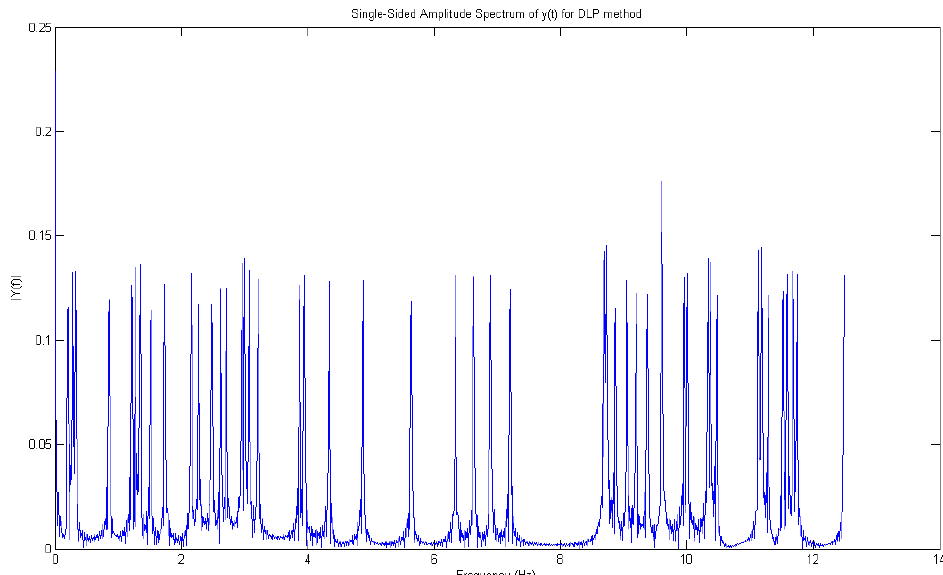
Figure 10. Frequency representation of all peaks (7–11) retrieved from the time domain using the DLP algorithm.